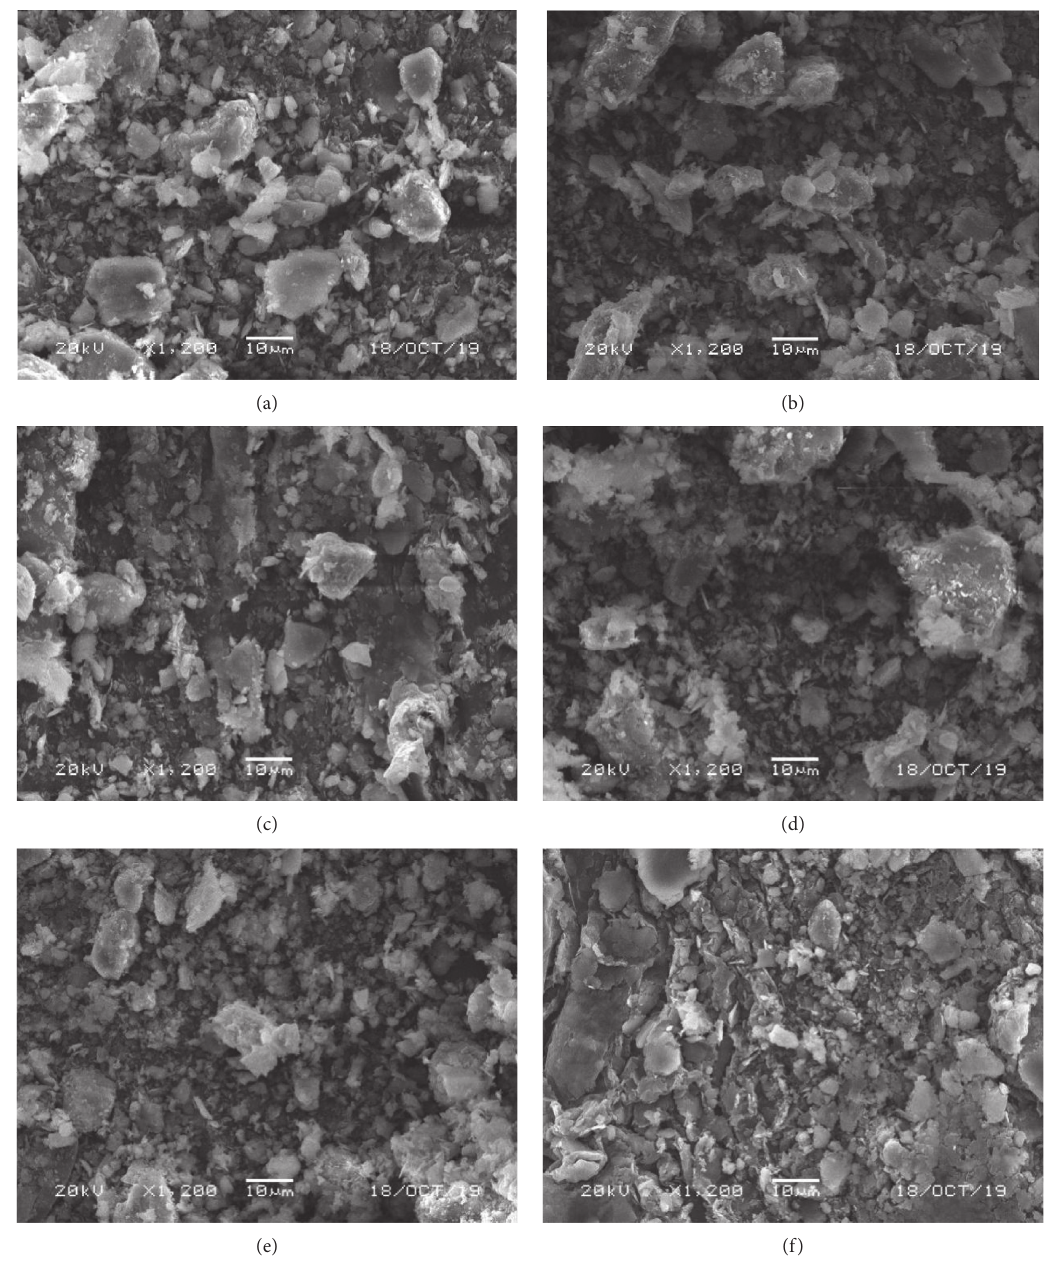
Figure 12: Microstructure of nano-modified cement soil: (a) NCS-28-10; (b) NCS-28-10-2; (c) NCS-28-10-4; (d) NCS-28-10-6; (e) NCS-28- 10-8; (f)